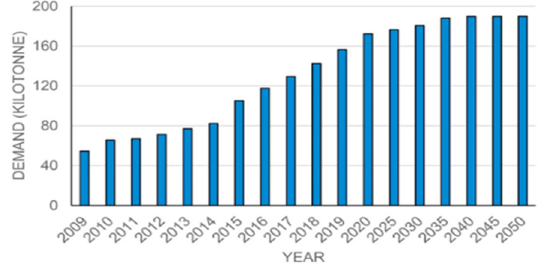
Figure 2. Increasing Carbon Fiber demand over the Years [11].